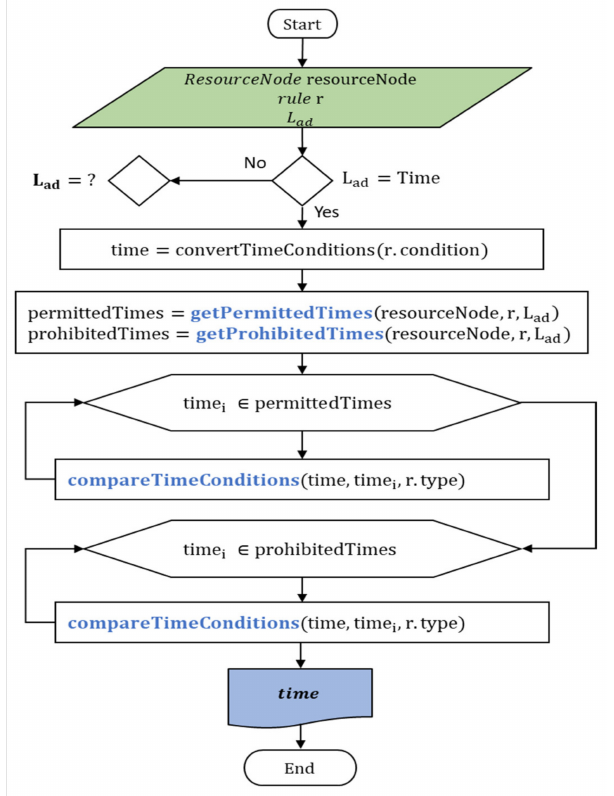
Figure 12. ConflictDetection Algorithm Flow